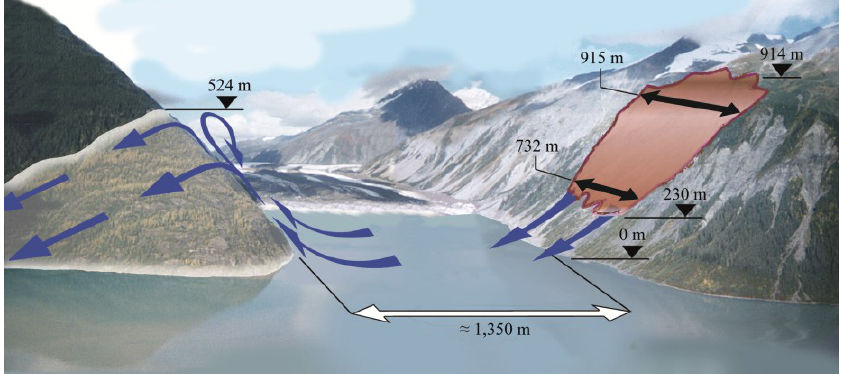
Figure 4. Arti t’ impre ion of 958 Lituya Bay rock lide generating a t unami of ~162 m in height destroying forest up to maximum run-up height of 524 m (adapted from Heller and Hager [26], with permission from © 2010 American Society of Civil